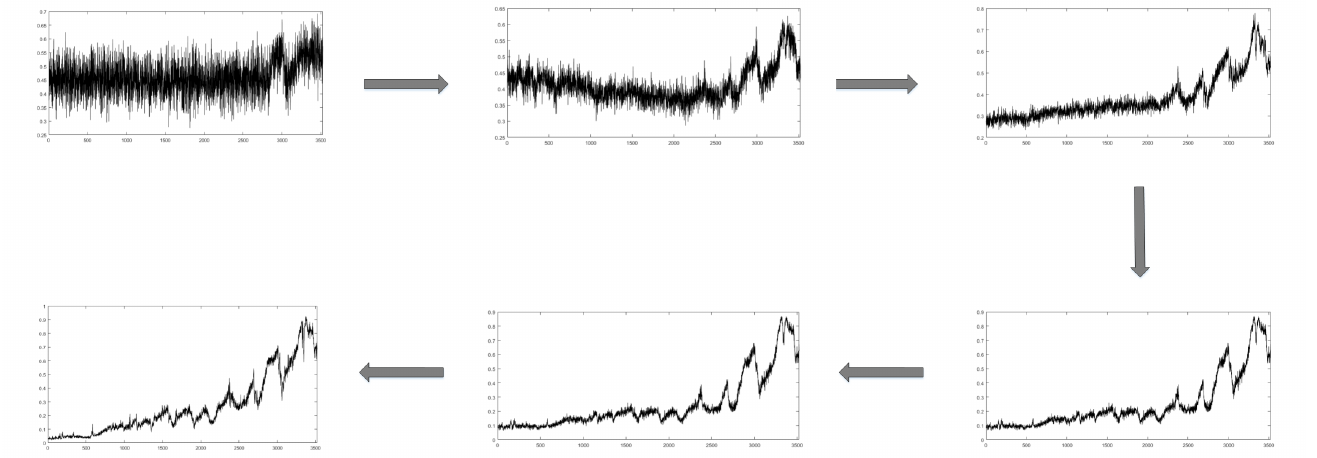
Figure 4. Generated spectral data during